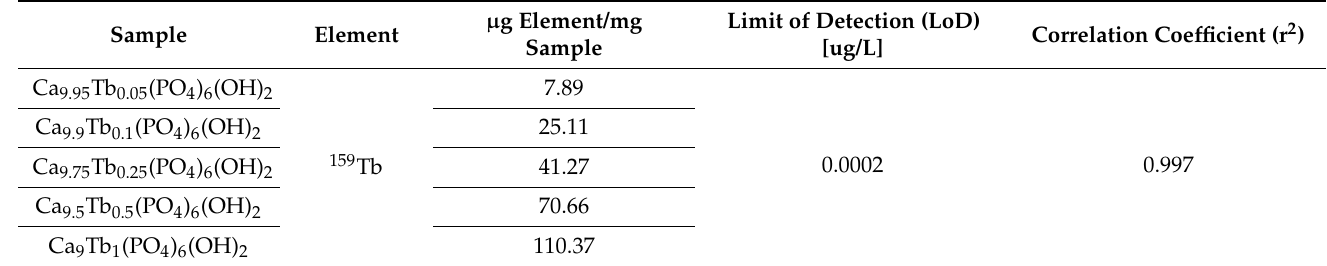
Table 1. Terbium ion contents for substituted